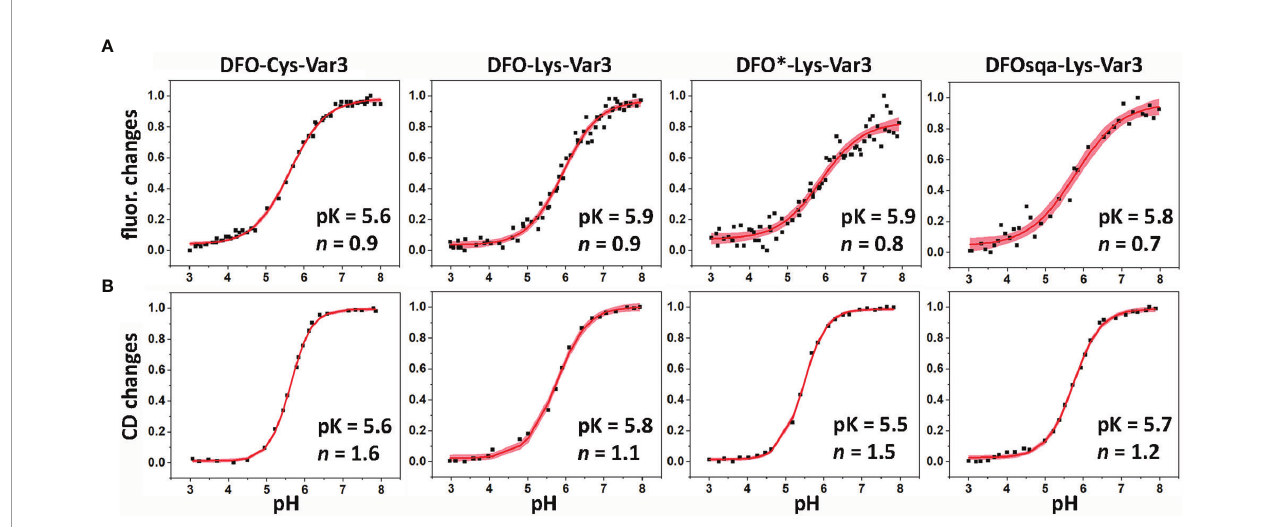
FIGURE 3 | The pH-dependent insertion of pHLIP agents into the lipid bilayers of POPC liposomes was studied by monitoring the changes in the position of the maxima of the tryptophan fl uorescence spectra (A) and ellipticity of the CD signals measured at 222 nm (B) as function of the pH. The data was fi tted using the Henderson-Hasselbalch equation. The fi tting curves (red lines) and 95% con fi dence intervals (pink areas) are